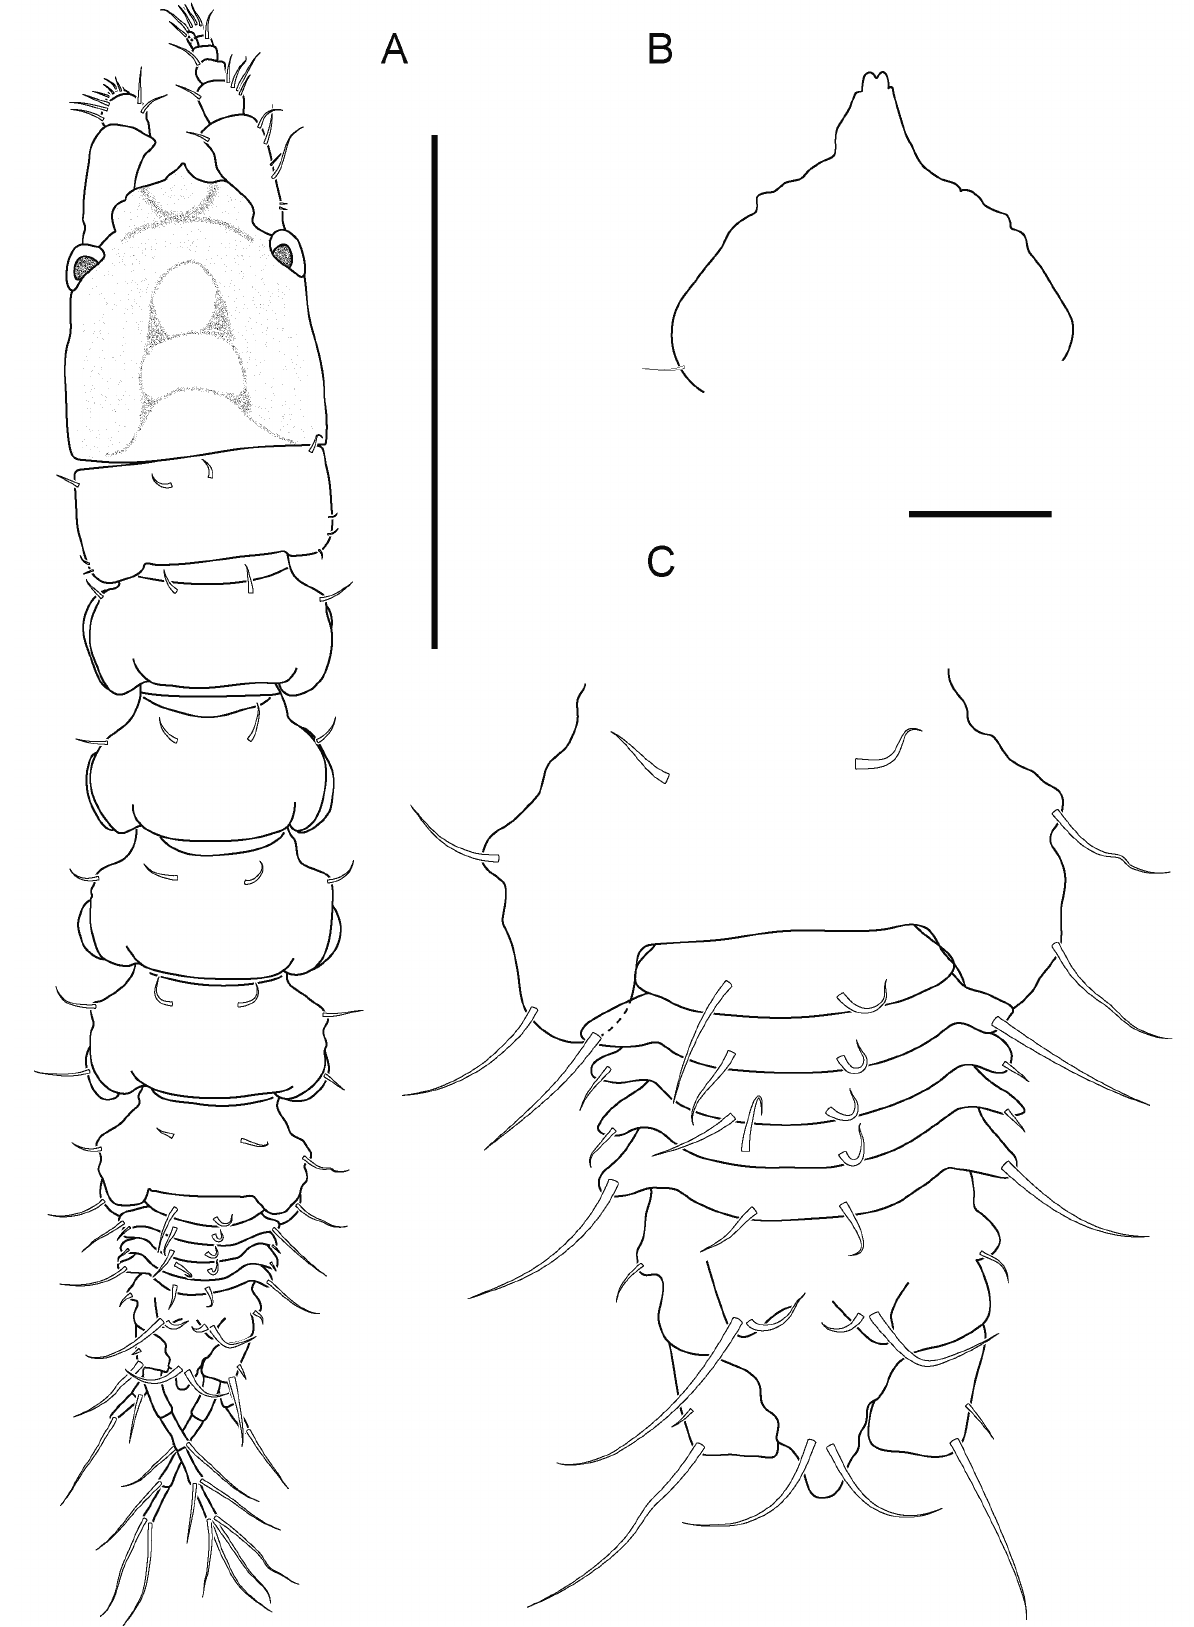
Figure 2. Apseudomorpha brasiliensis sp. nov. Holotype, ovigerous female (MNRJ 29863). A Dorsal view; B enlargement of ros- trum; C enlargement of pleon and pleotelson. Scale bars: 1.0 mm for A and 0.1 mm for B–C